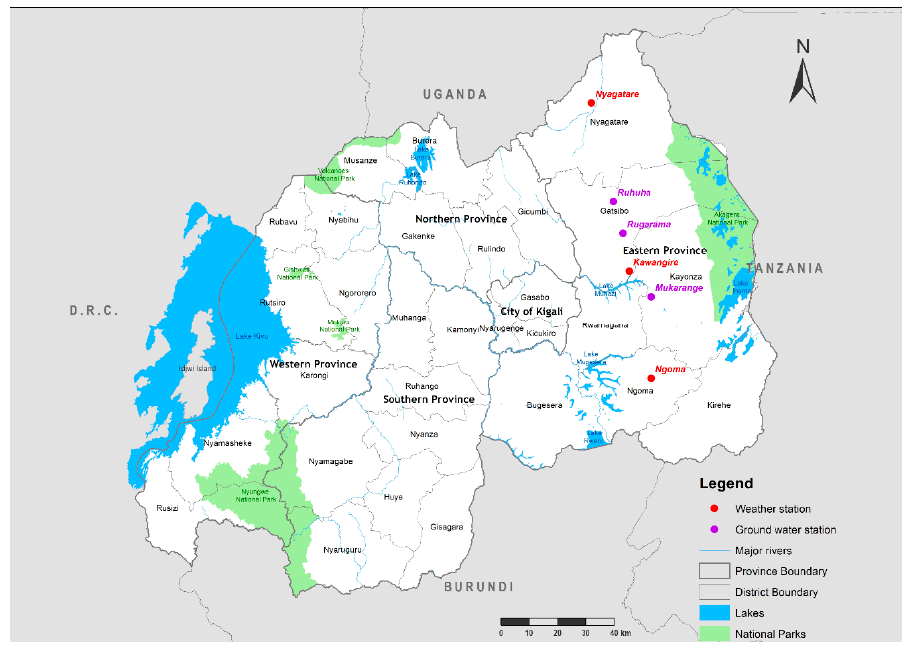
Figure 1. Map of Rwanda shows the location of the groundwater monitoring wells and weather stations in the eastern